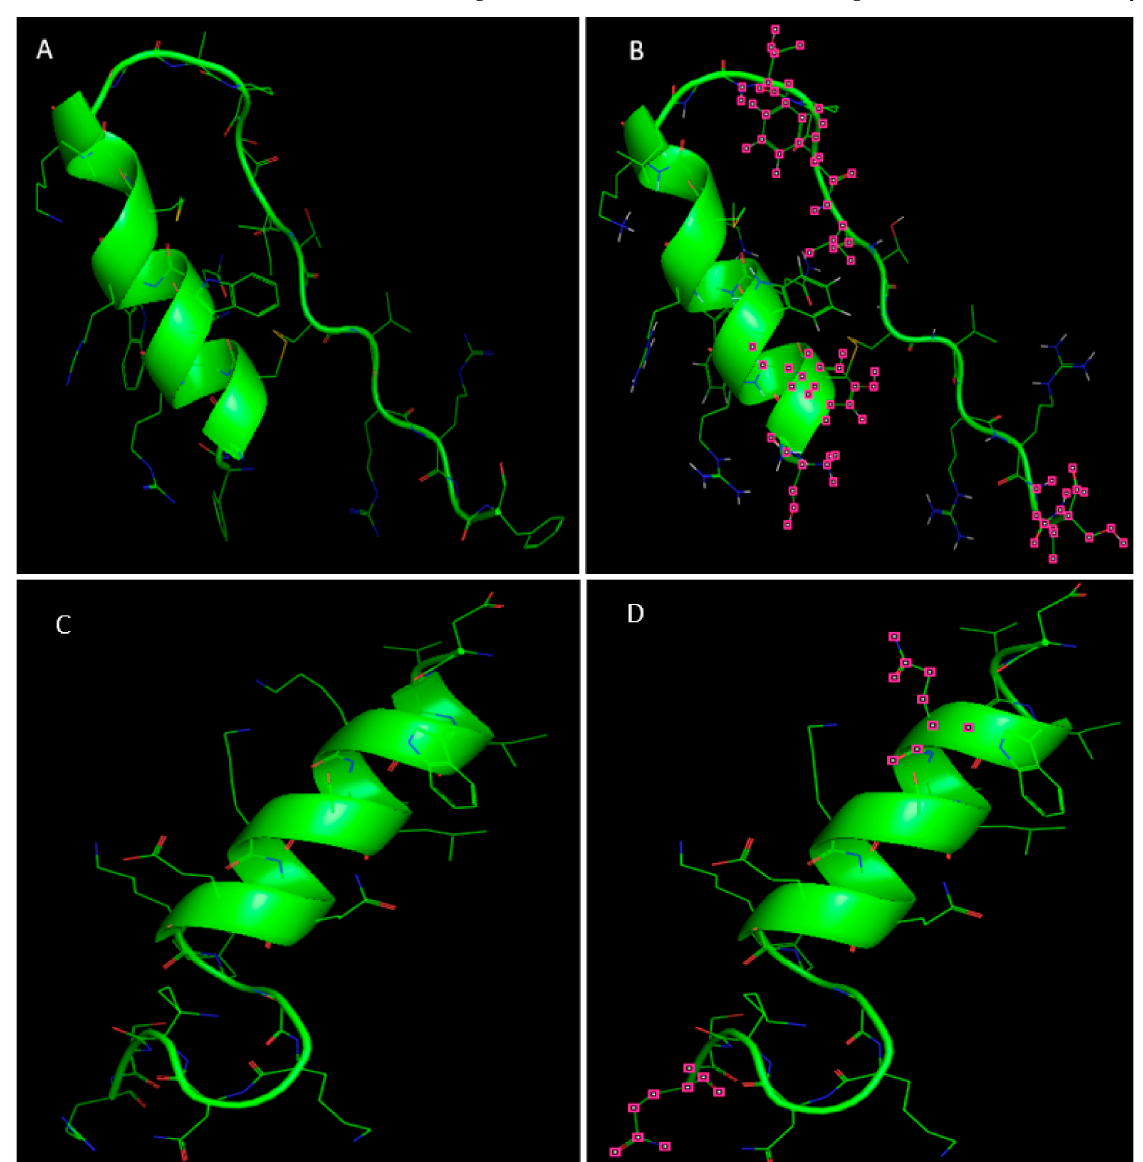
Figure 3. In silico structures of deer and bovine lactoferricin (Lfcin) and lactoferrampin (Lfampin). ( A ) Structure of bovine Lfcin (FKCRRWQWRMKKLGAPSITCVRRAF) (PDB ID: 1BLF); ( B ) Structure of deer Lfcin (SKCYRWQWRMKKL- GTPFVTCVRRTS) displayed using PyMOL; ( C ) Structure of bovine Lfampin (265–284) (DLIWKLLSKAQEKFGKNKSR) (PDB ID: 1BLF); ( D ) Structure of deer Lfampin (265–284) (DLIWQLLSKAQEKFGKNKSQ) displayed using PyMOL. Pink squares indicate differences between deer and bovine Lfcin and